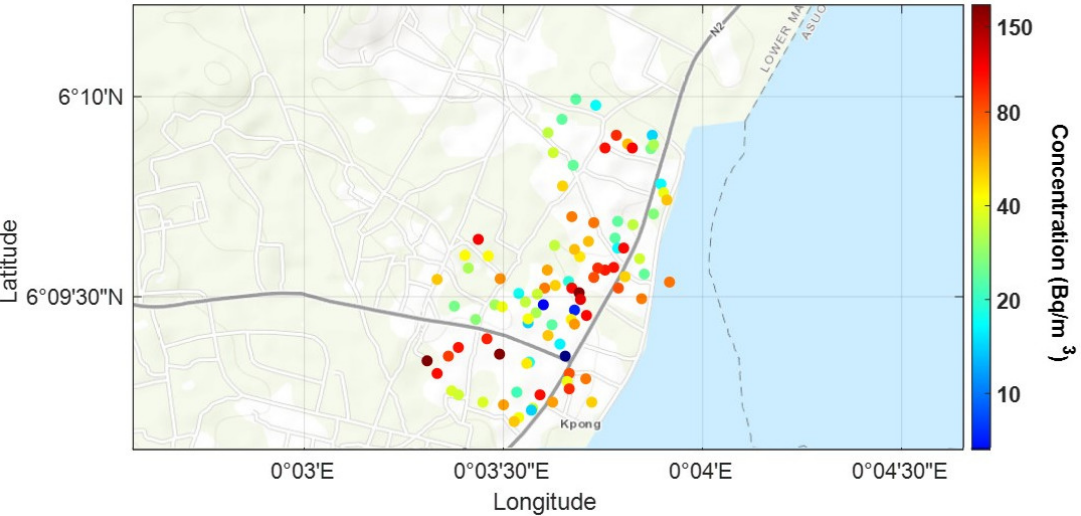
Figure 3. The GPS location of the dwellings of the participants that agreed to participate in the study in Kpong, Ghana.